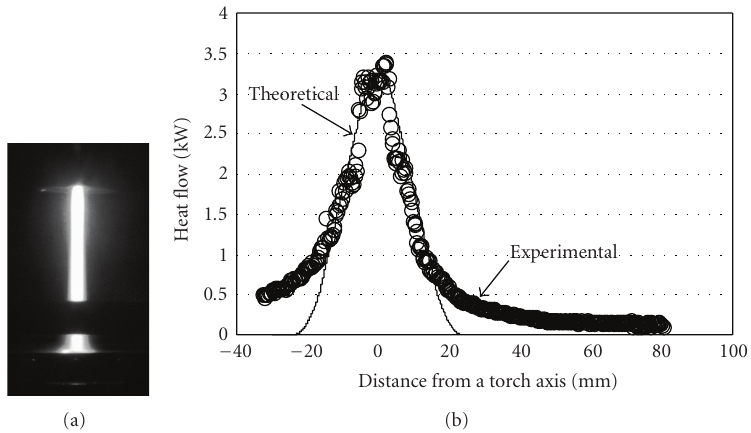
Figure 7: Comparison of experimental variation of heat flow to the calorimeter with the theoretical one under no magnetic field ( Y = 0).